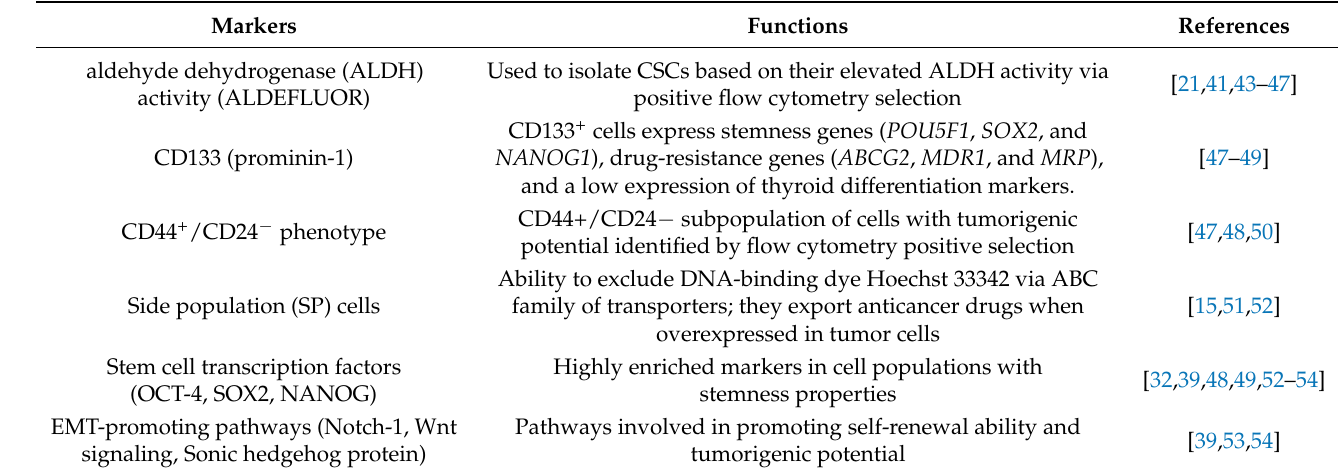
Table 1. Markers that are used to identify thyroid